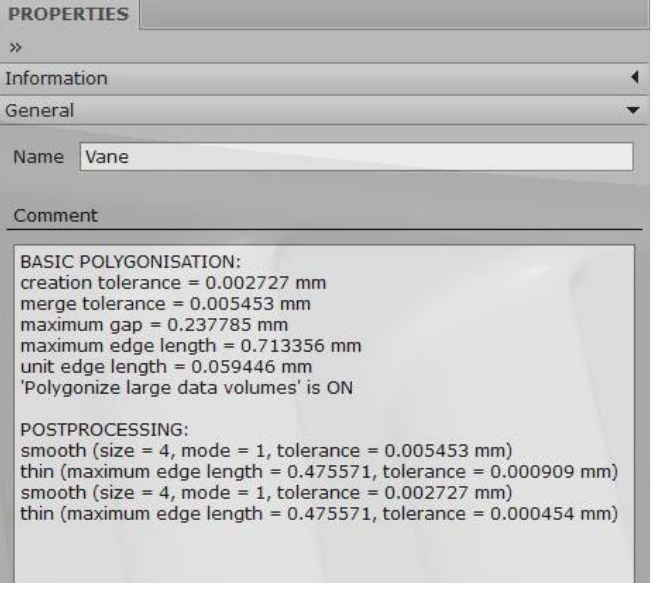
Figure 2. 3D-scanning properties.